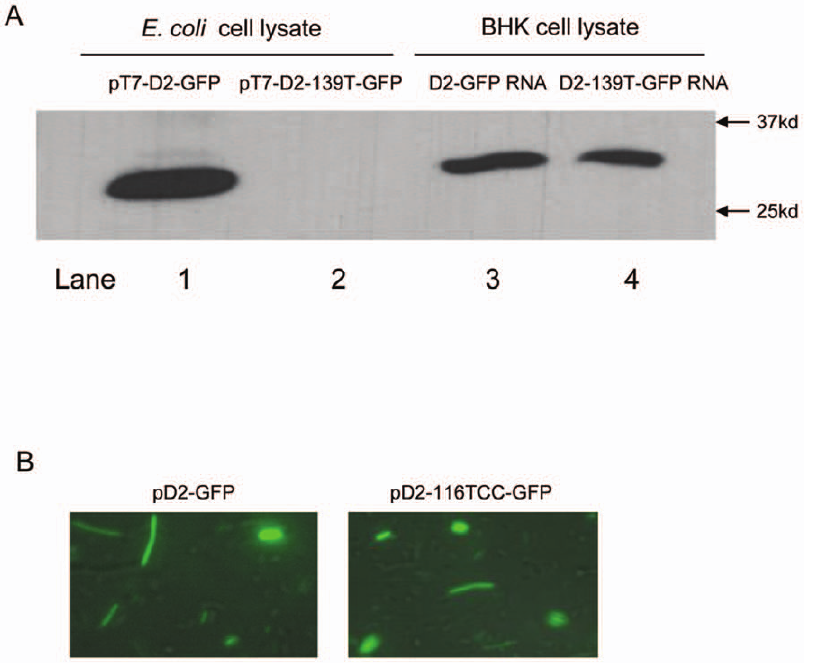
Figure 3. D2-GFP translation initiates in Ecoli at an alternate start codon (139AUG) by a Shine-Dalgarno independent mechanism. (A) Western blots of E. coli (lanes 1 and 2) and BHK (lanes 3 and 4) cell lysates expressing D2-GFP and D2-139T-GFP probed with anti-GFP antibodies. E. coli was transformed with either pT7-D2-GFP or pT7-D2-139T-GFP. BHK cells were transfected with in vitro transcribed D2-GFP and D2-139T-GFP RNA. (B) Fluorescent microscopy images of E. Coli cells transformed with either pT7-D2-GFP or pT7-D2-116TCC-GFP.